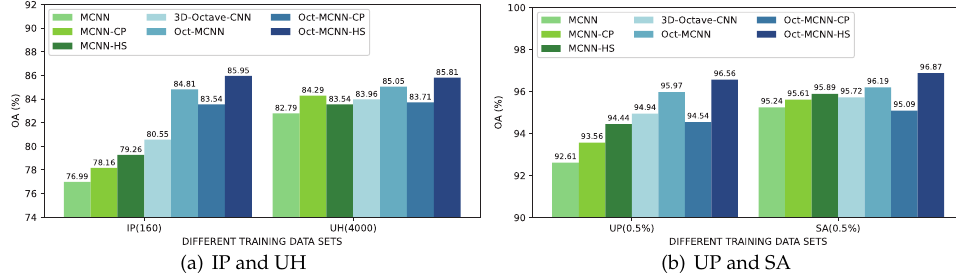
Figure 9. Classification OA results (%) of models equipped with different